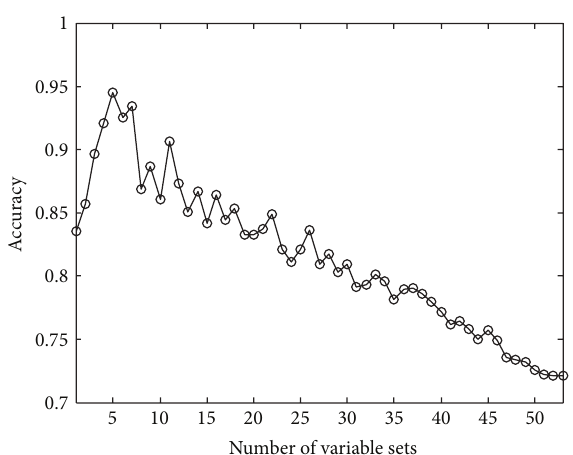
Figure 9: The accuracy with different feature sets to indentify Fault9 and Fault11 with testing data.